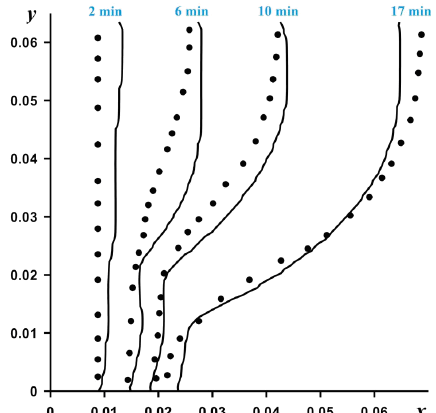
Figure 2. Comparison of obtained numerical data (solid line) and experimental data [25].